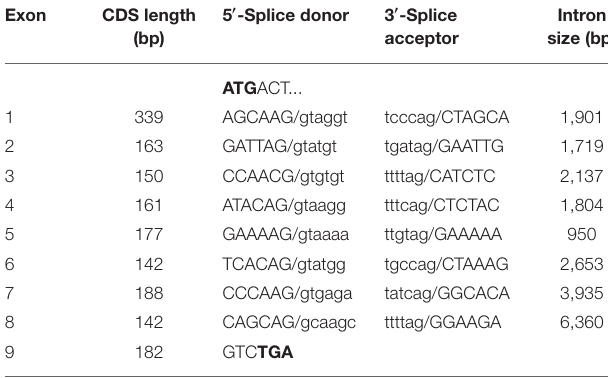
Nucleotide sequences of the exon/intron junctions are indicated. Exon sequences are shown in uppercase letters, intron sequences are in lowercase. Start codon and stop codon are indicated in